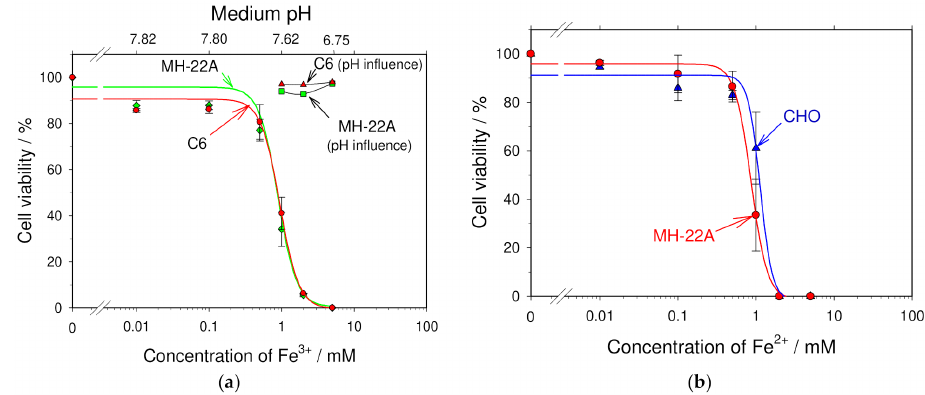
Figure 6. Influence of iron ions on cell viability. ( a ) The influence of Fe 3+ ions on the viability of mouse hepatoma MH-22A and rat glioma C6 cells. The ordinate axis shows the cell viability and abscissa axis—what concentration of Fe 3+ ions was added into the medium. The cells were grown in the medium supplemented with various amounts of aqueous FeCl 3 and the cell viability was estimated by a colony–forming assay. The influence of the medium pH (upper abscissa) on the cell viability (ordinate) is also shown. ( b ) The influence of Fe 2+ ions on the viability of mouse hepatoma MH-22A and Chinese hamster ovary CHO cells. The abscissa axis shows what concentration of Fe 2+ ions was added into the medium. The cells were grown in the medium supplemented with